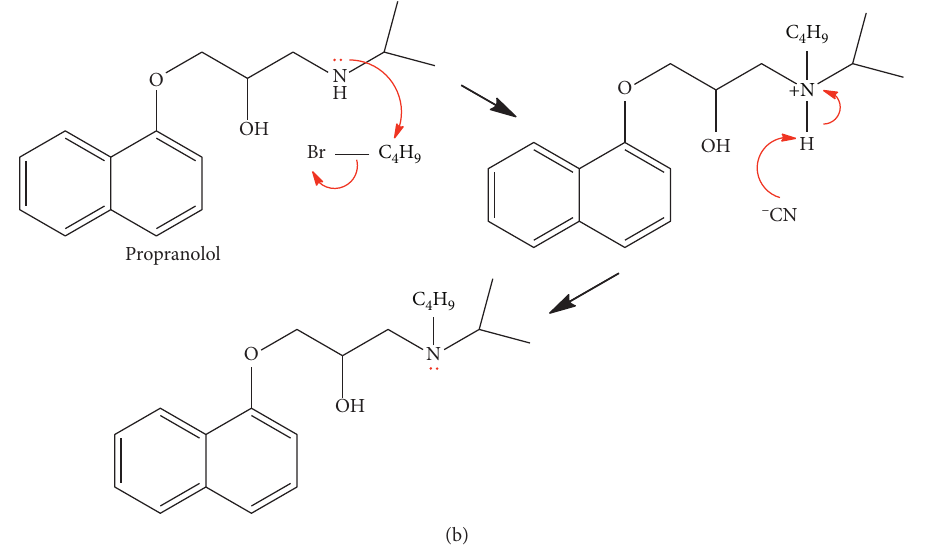
Figure 8: (a) Oxidation reaction mechanism of propranolol using pyridinium chlorochromate; (b) amine alkylation reaction mechanism between propranolol and n-butyl bromide. Table 2: The solubility of propranolol derivatives.